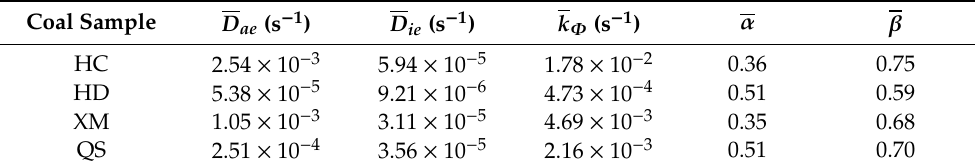
Table 7. Average gas di ff usion parameters of experimental coal samples.